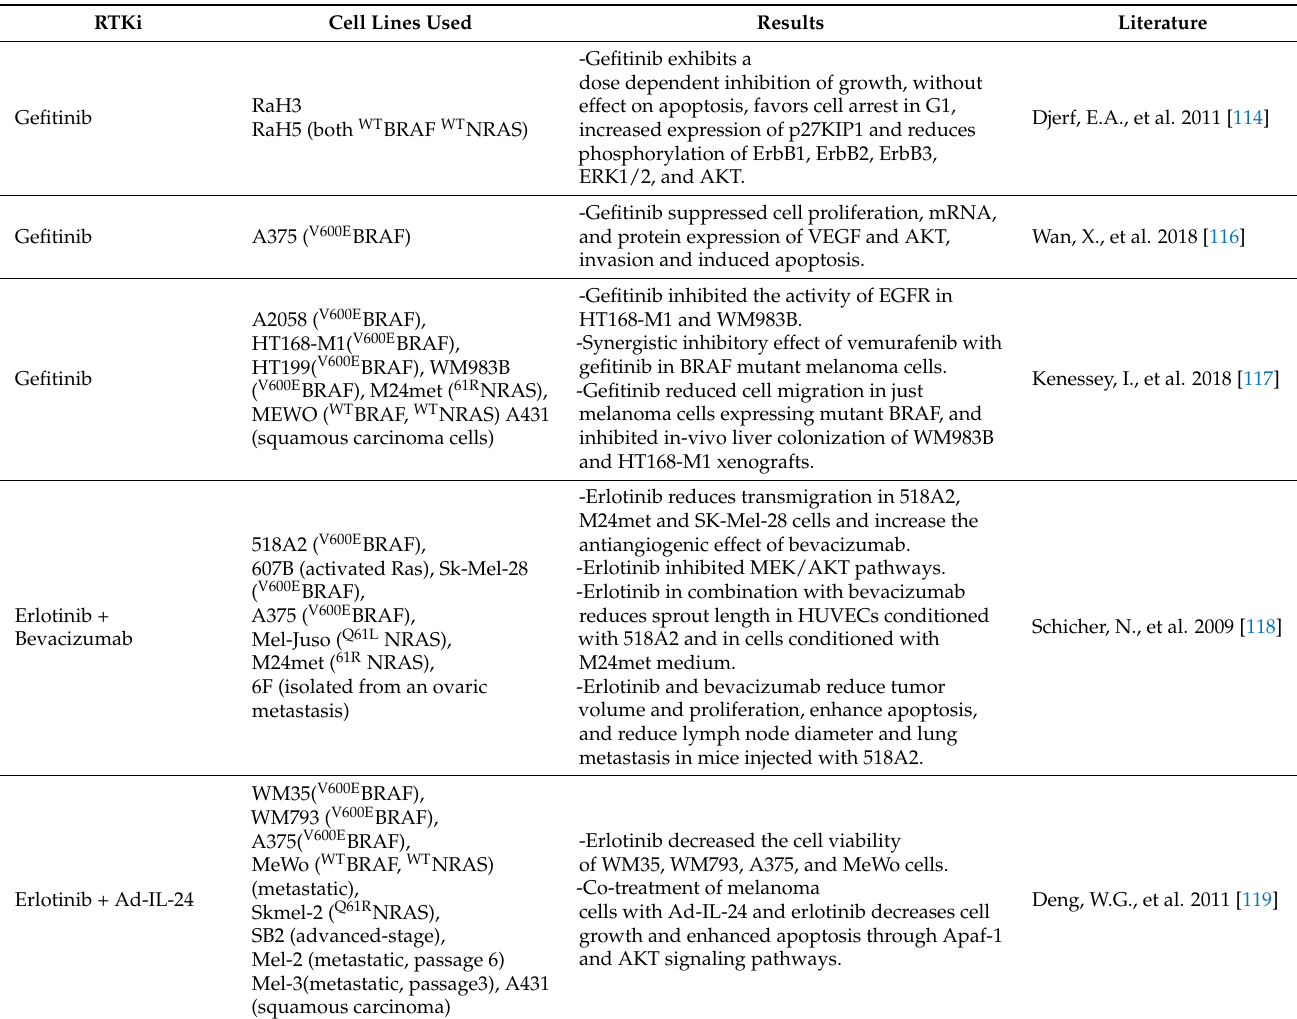
Table 6. EGFR inhibitors in melanoma preclinical